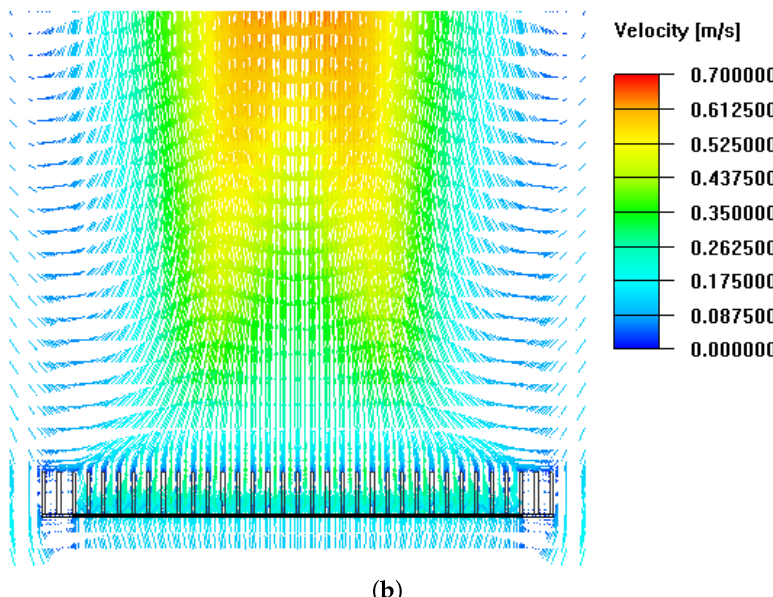
Figure 8. Velocity vectors plotted at the mid-plane in the fin channel without openings ( a ) and with openings ( b ) in the transverse direction, illustrating the vertical flow of air through openings and the plume structure ( L = 512 mm, W = 512 mm, H = 40 mm, and ∆ T = 40 ◦ C).